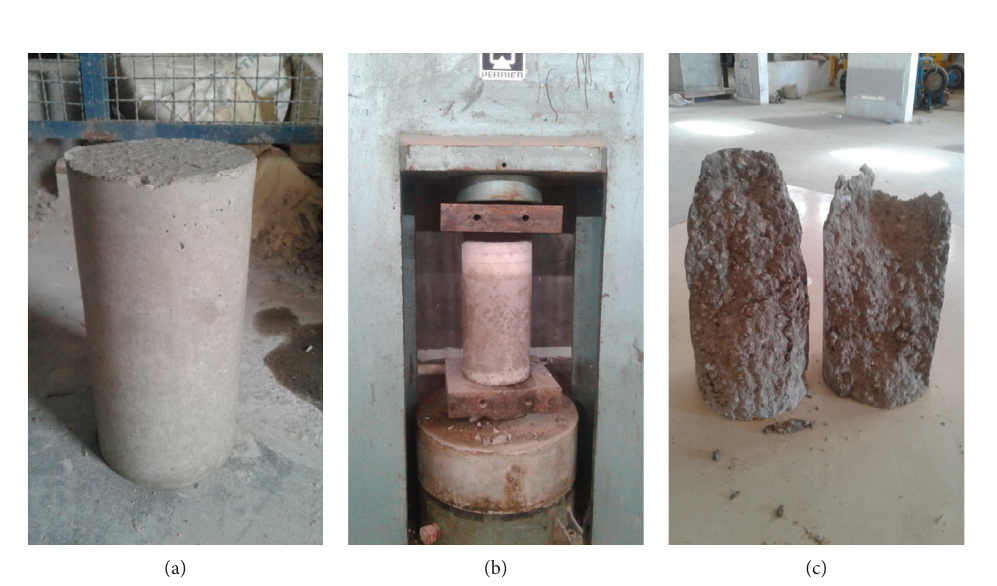
Figure 5: Compressive strength